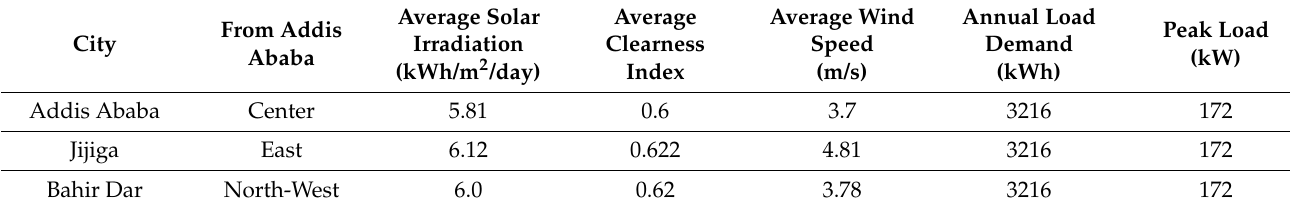
Table 1. Geographical, climatic, and load details of the selected areas.